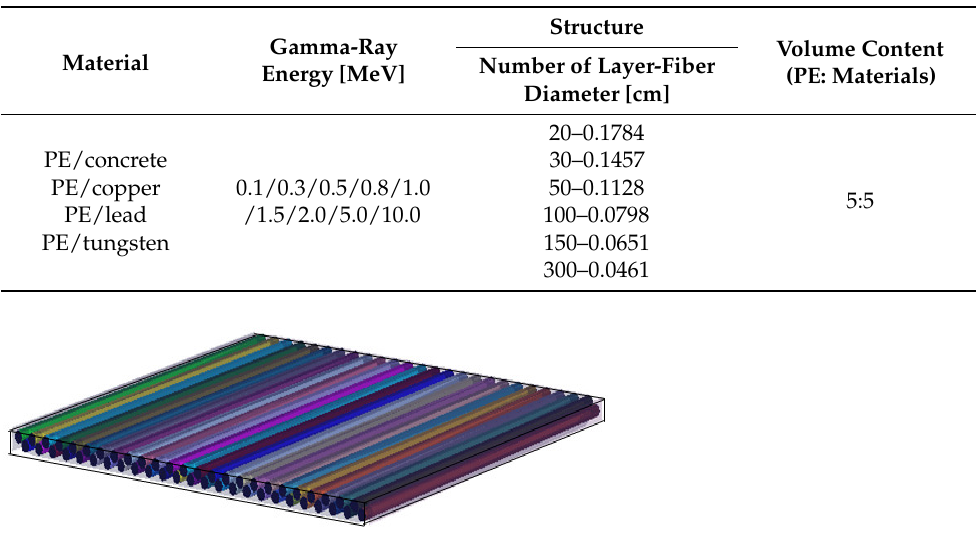
Figure 3. Geometry of film type fibrous composite.